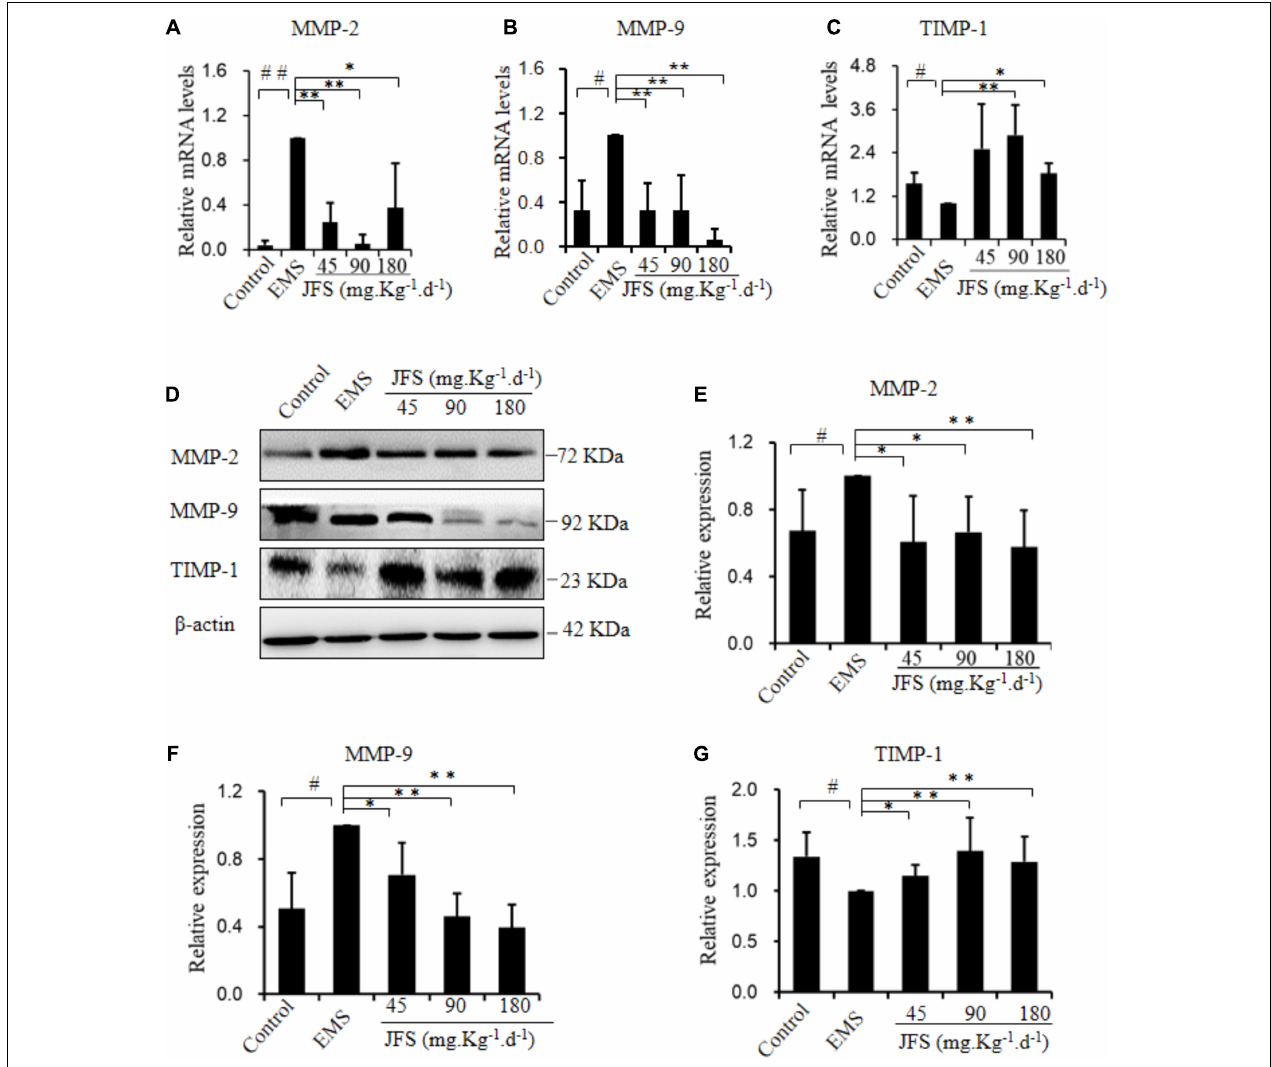
FIGURE 6 | Effect of JFS on invasion and metastasis. (A–C) The mRNA levels of MMP-2, MMP-9, and TIMP-1 were detected by qPCR in different groups. (D–G) The protein levels of MMP-2, MMP-9, and TIMP-1 were detected by western blotting, and the ratio of MMP-2, MMP-9, and TIMP-1 with β -actin were